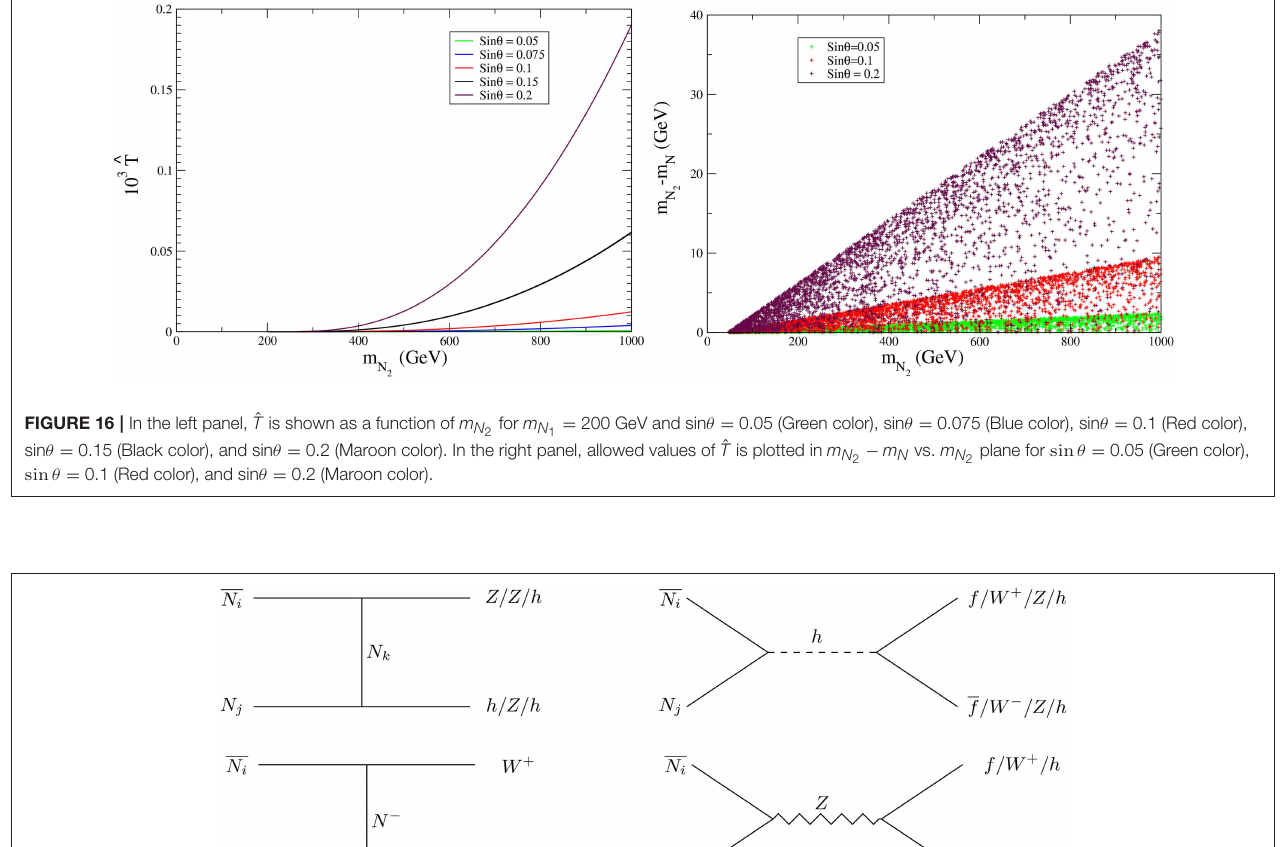
j ) and co-annihilation ( i =